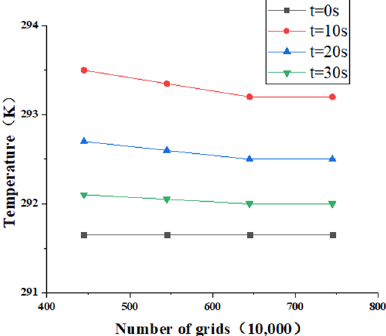
Figure 4. Grid-independence verification.